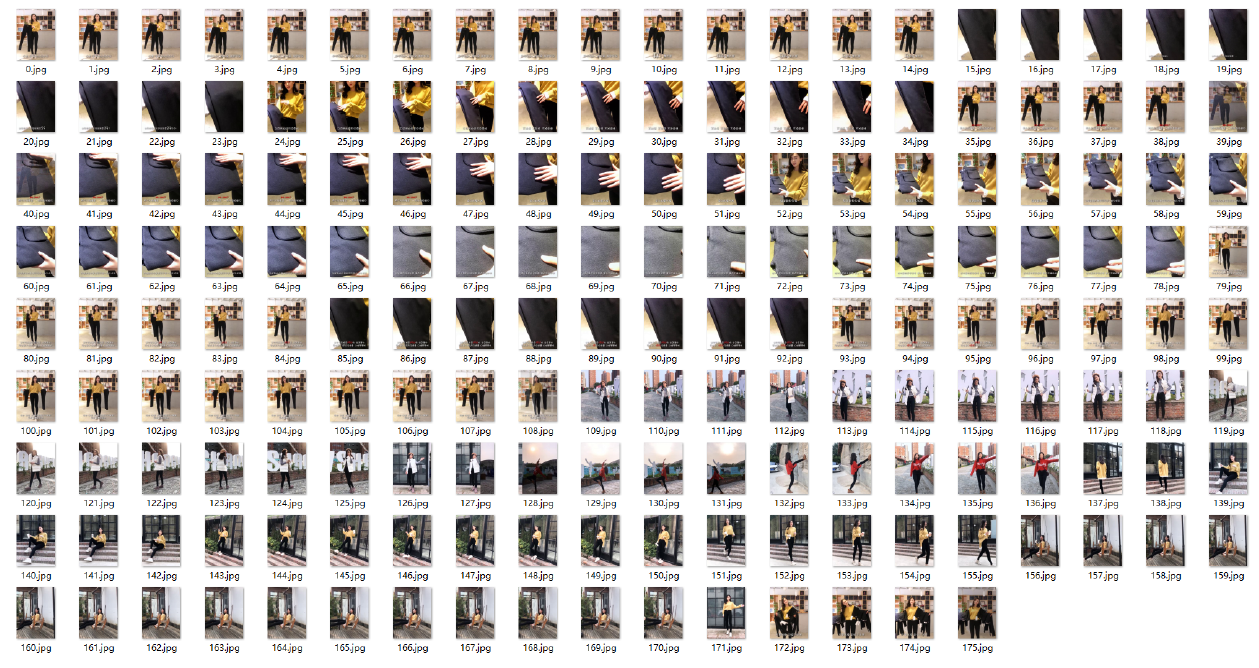
Figure 3. Extraction results of differential frames.